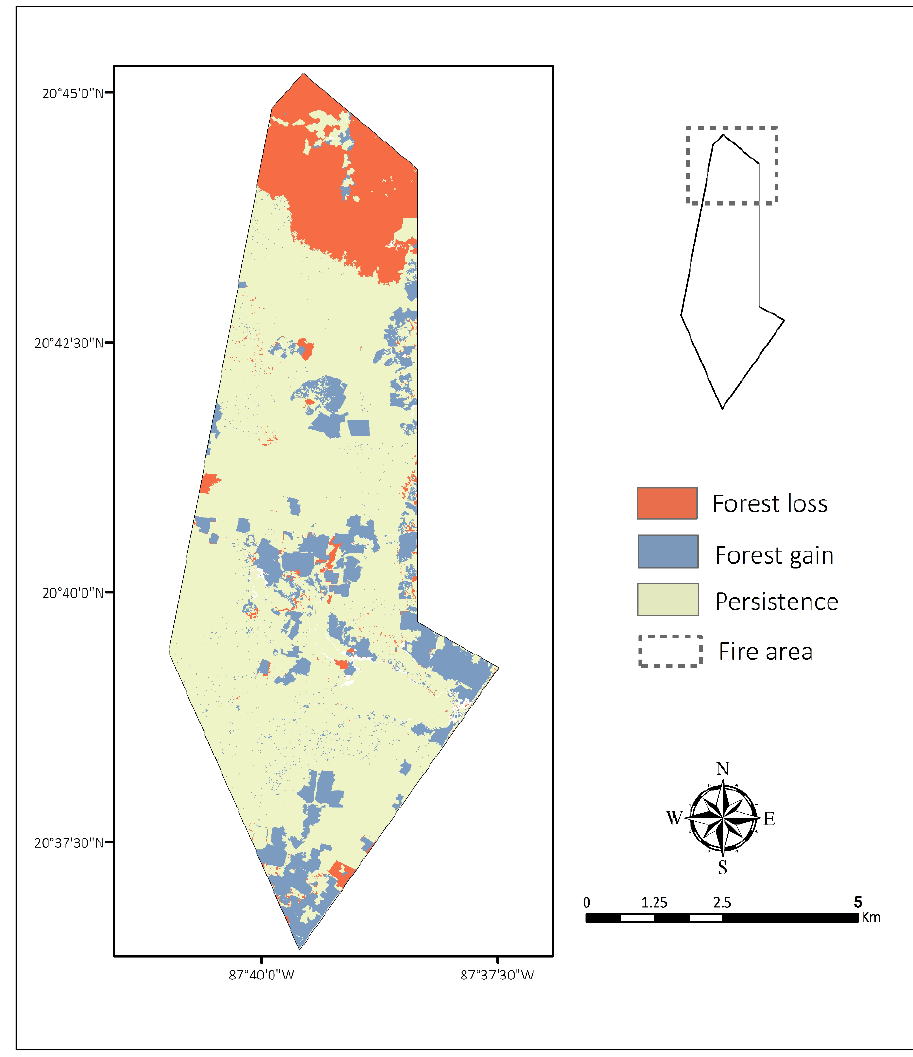
Figure 3. Spatial distribution of forest change (gain and loss), and persistence between 2003 and 2015. Forest refers to the three categories (young secondary, medium secondary, and old forest). Gains mostly include the transition from milpas to young secondary forest and from young secondary forest to medium secondary forest.